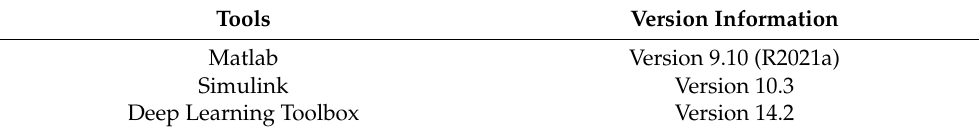
Table 3. Tool information.